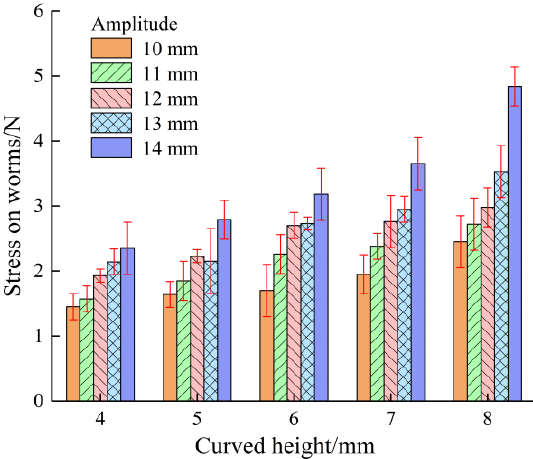
Figure 15. Ultimate pressure on black soldier fly larvae at different amplitudes and curved